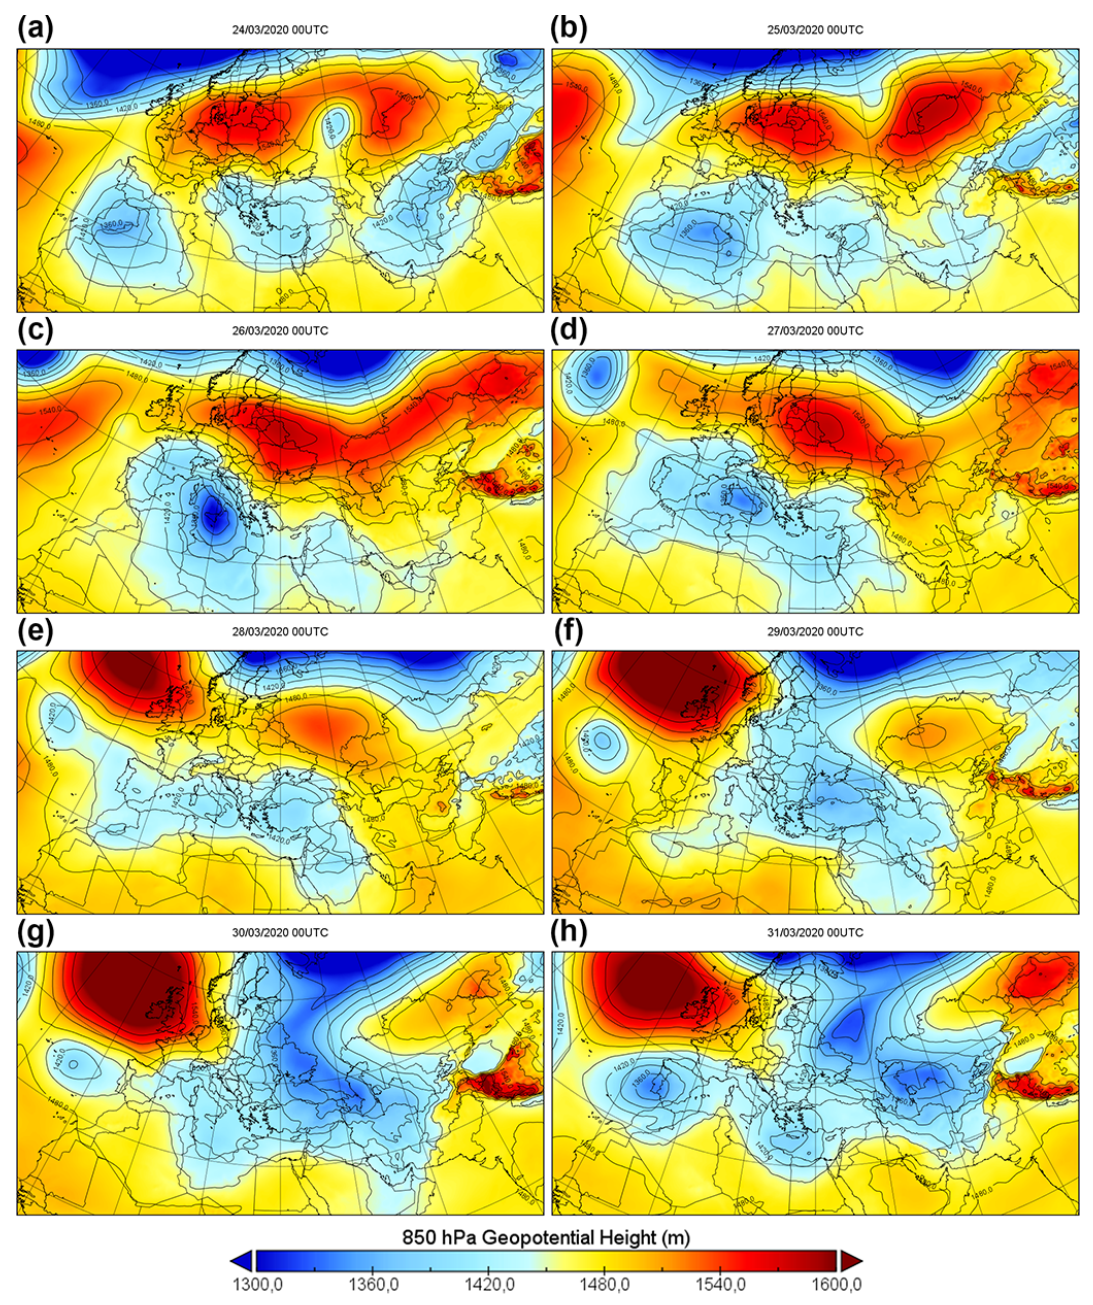
Figure 1. Maps of the geopotential (colors and isolines, in m 2 s − 2 ) at 850hPa relative to each day in the period from 24 to 31 March at 00:00UTC (a–h) . The maps were created with Panoply starting from ERA5 reanalysis. Panels (a) to (h) refer to the respective days from